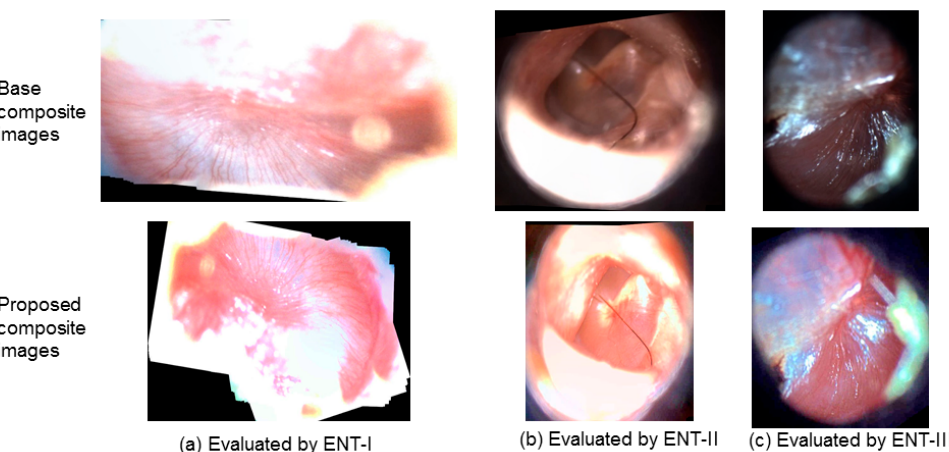
Figure 8. Examples of the same evaluation score for both composite images. The first row shows the images generated by the base processes and the second row shows the images by SelectStitch. Each column indicates also the number of reader and each reader gives the score of 2 for both base and the proposed image.